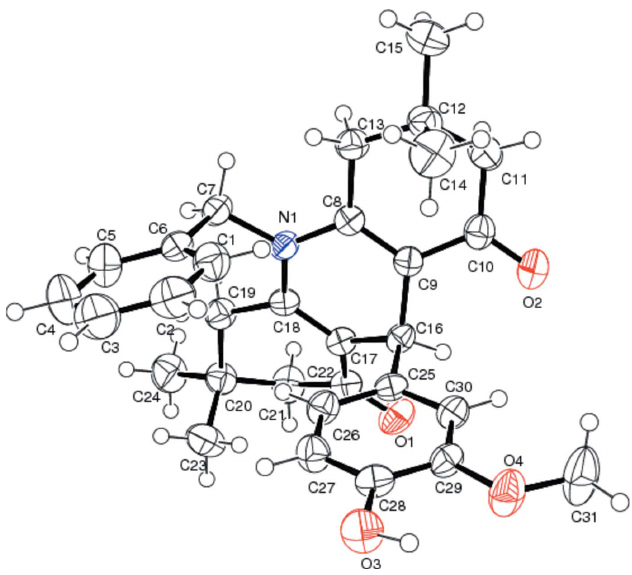
Figure 1 The molecular structure of the title compound. Displacement ellipsoids are drawn at the 50% probability level.